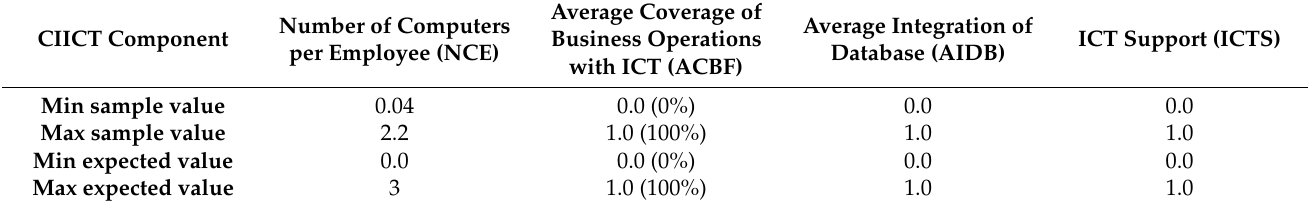
Table 4. CIOICTI components and their value